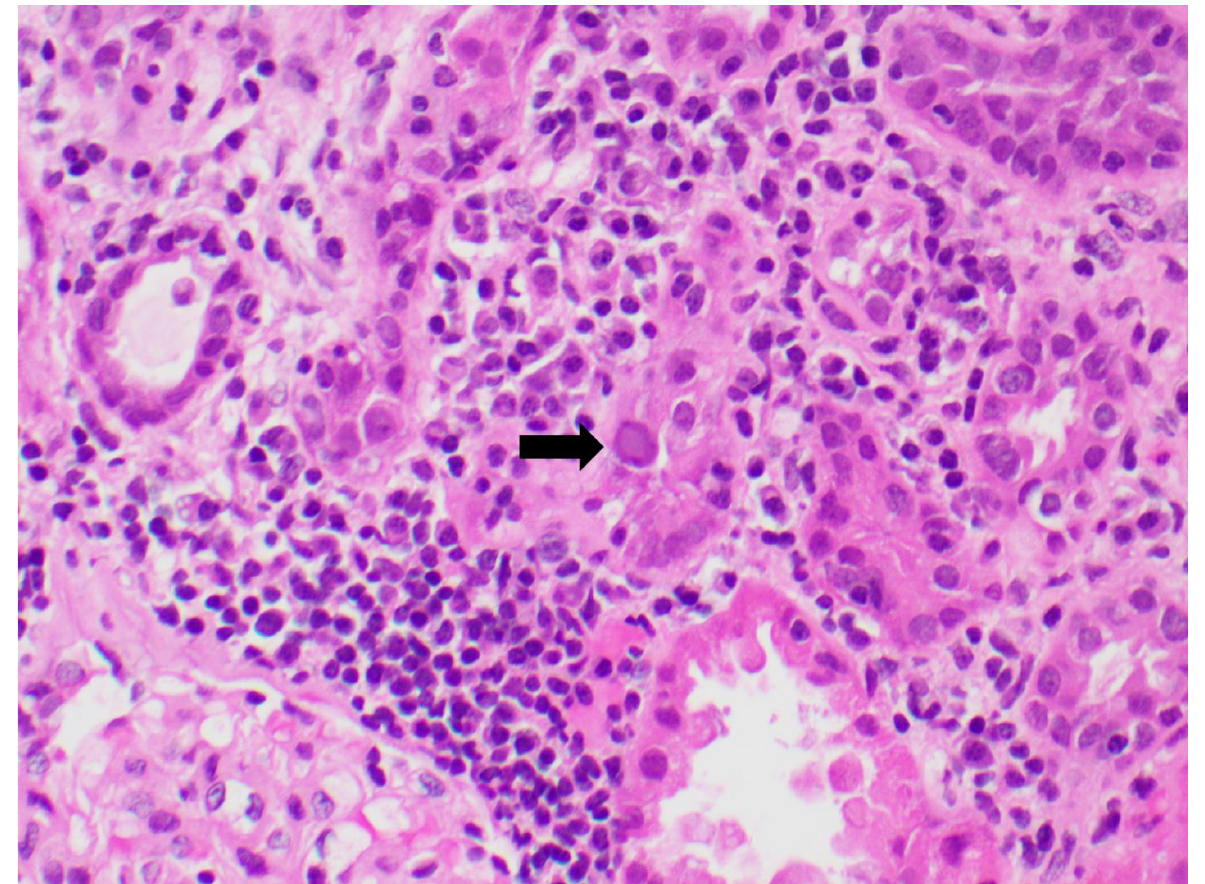
Figure 4. Lymphoplasmacytic interstitial inflammation surrounding a tubule containing an epithelial cell with a viral inclusion (arrow). H&E 400×.